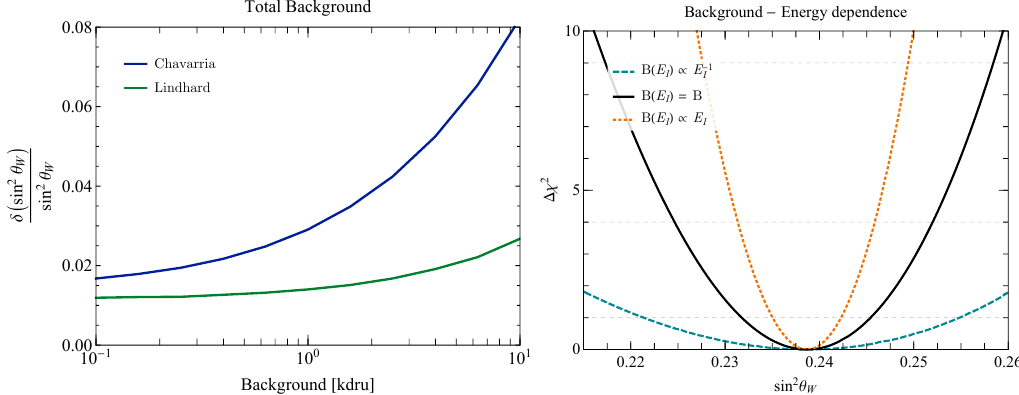
Figure 4 . Left: precision on the determination of sin 2 θ W as a function of background rates, as- suming a flat background spectrum, for Chavarria (blue) and Lindhard (green) quenching scenarios. Right: benchmark sensitivity to sin 2 θ W for different background spectral shapes: flat (black solid), E − 1 (dark cyan dashed) and E I (dotted I